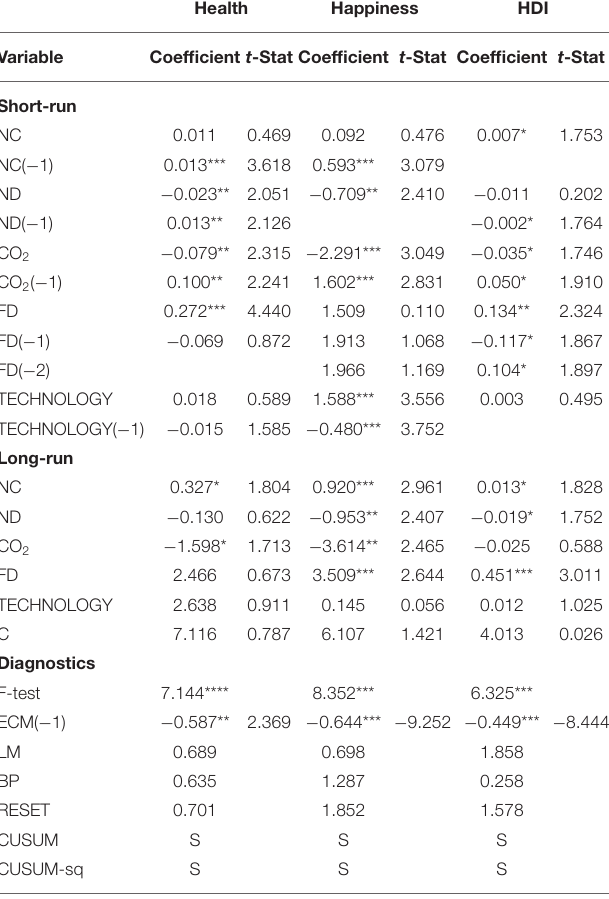
TABLE 4 | ARDL estimates of health, happiness, and HDI. Health Happiness